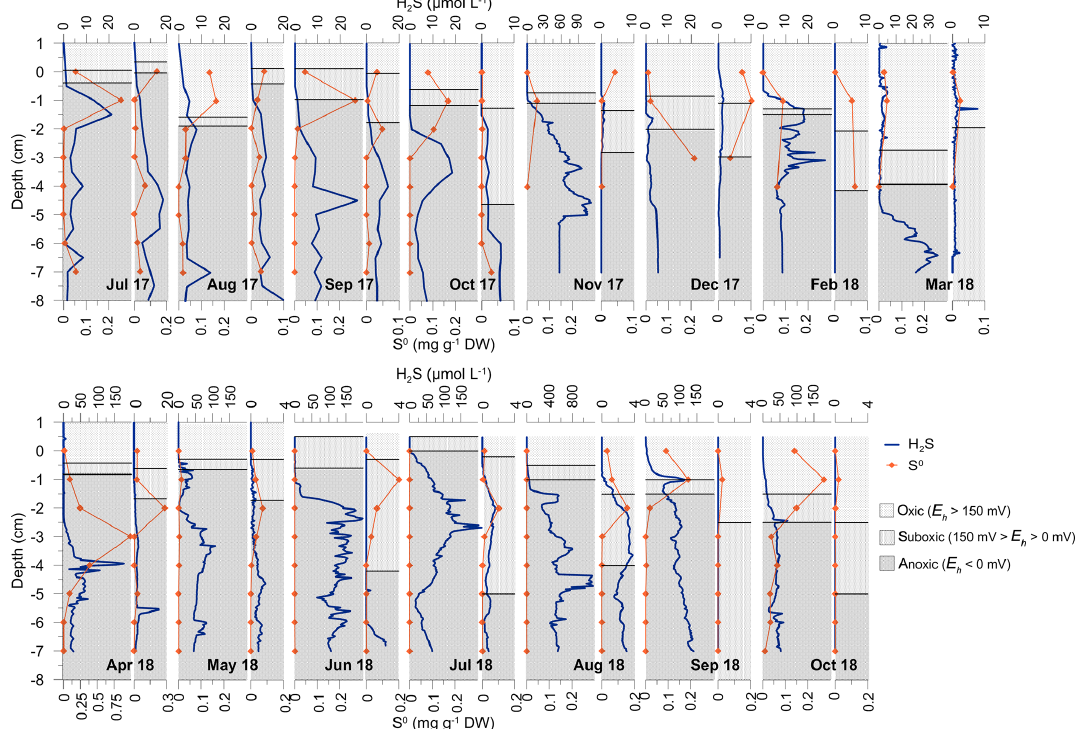
Figure 7. Depth profiles of H 2 S and S 0 concentrations in vegetated and nonvegetated sediment (adjacent narrow graphs). The redox potential ( E h ) in both sediments is shown as areas corresponding to oxic ( E h > 150mV), suboxic (150 > E h > 0mV) and anoxic ( E h < 0mV)